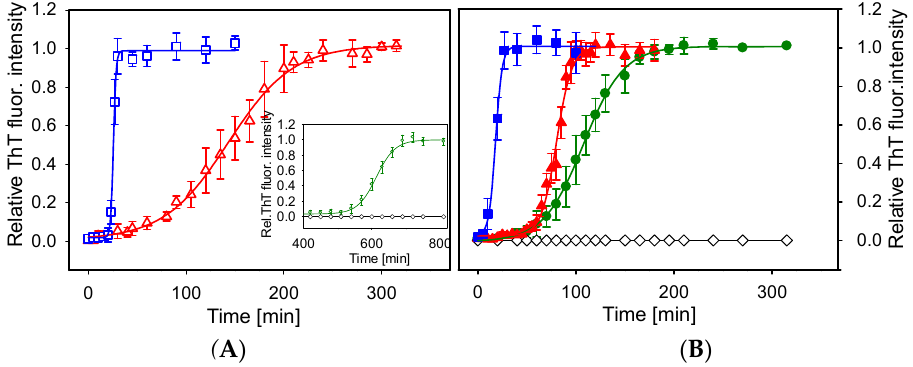
Figure 1. Kinetics of lysozyme fibrillization in the absence and presence of an increasing ( v / v ) concentrations of ILs. ( A ) EMIM-ac: 1%—red open triangles; 5%—blue open squares. Inset: EMIM-ac: 0%—black open diamonds; 0.5%—green open circles. ( B ) EMIM-BF 4 : 0%—black open diamonds; 0.5%—green circles; 1%—red triangles; 5%—blue squares. Lysozyme concentration was 2 mg/mL.